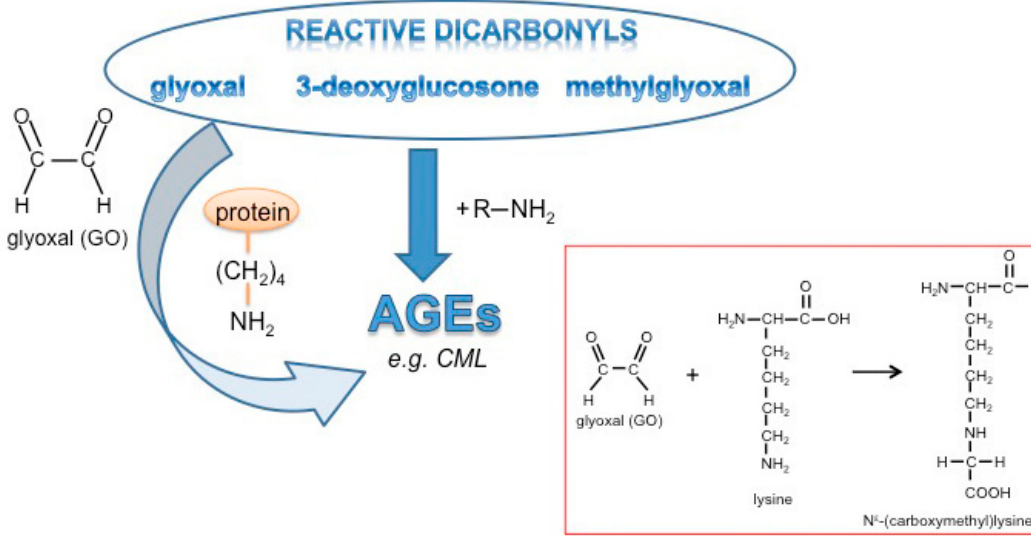
Figure 1. Glycation and formation of advanced glycation end products (AGEs).